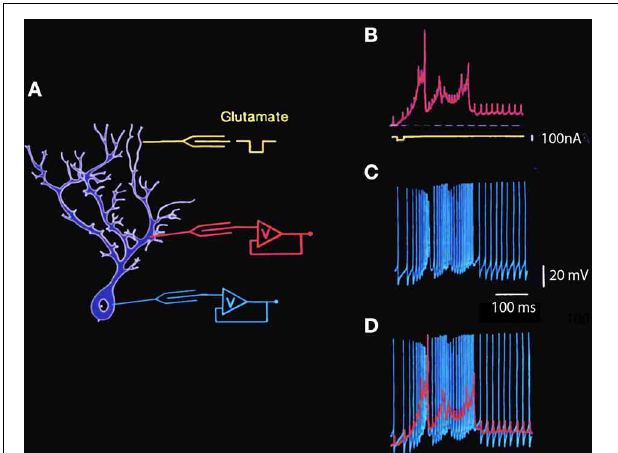
FIGURE 1 | Simultaneous intracellular recording from Guinea pig cerebellar Purkinje cell dendrite and soma in vitro . (A) Diagram of intracellular recording sites at somatic and dendritic levels and the location of the extracellular glutamic acid iontophoretic application site. (B) Intradendritic recording. The large amplitude wide action potentials are Ca-dependent while the smaller fast action potentials represent the passive invasion of the somatic action potentials into the dendritic tree. Note the presence of a sustained plateau depolarization at the dendritic level following the spiking phase of the dendritic response. (C) Simultaneous intrasomatic recording showing fast somatic Na-dependent action potentials. Note that each of the large somatic spikes is seen at dendritic level with a short delay and that the calcium dependent dendritic spikes generate high frequency spiking as somatic level. (D) Superposition of dendritic (red) and somatic (blue) spikes to illustrate the temporal relationship between somatic and dendritic spikes and plateau amplitudes (Llinás and Sugimori, 1980a,b. This example is